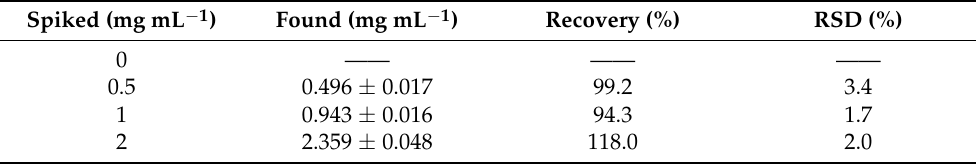
Table 2. Recovery and precision of the method for the detection of glucose ( n = 3). Spiked (mg mL − 1 ) Found (mg mL − 1